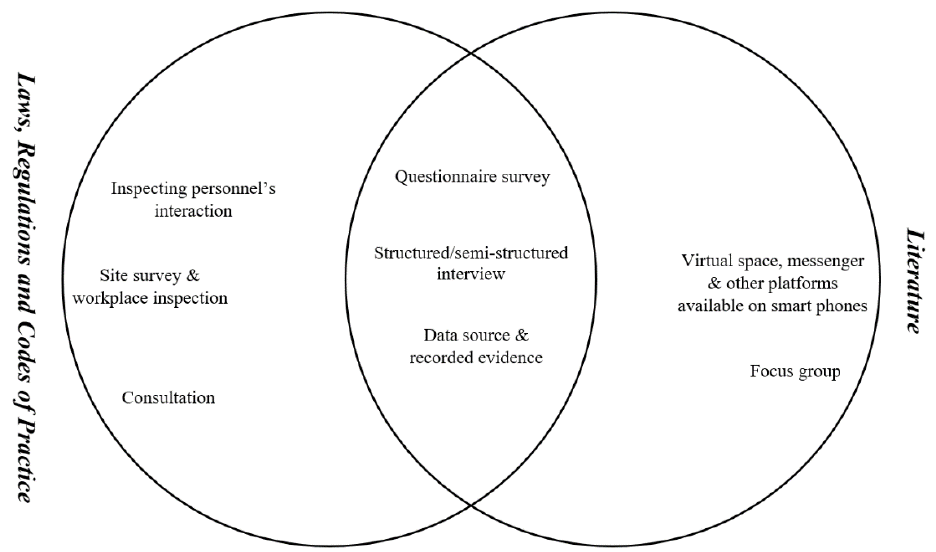
Figure 4. Convergence (LOS > 0.60, F lit > 0.20, F cop > 0.20) and divergence between the retrieved liter-